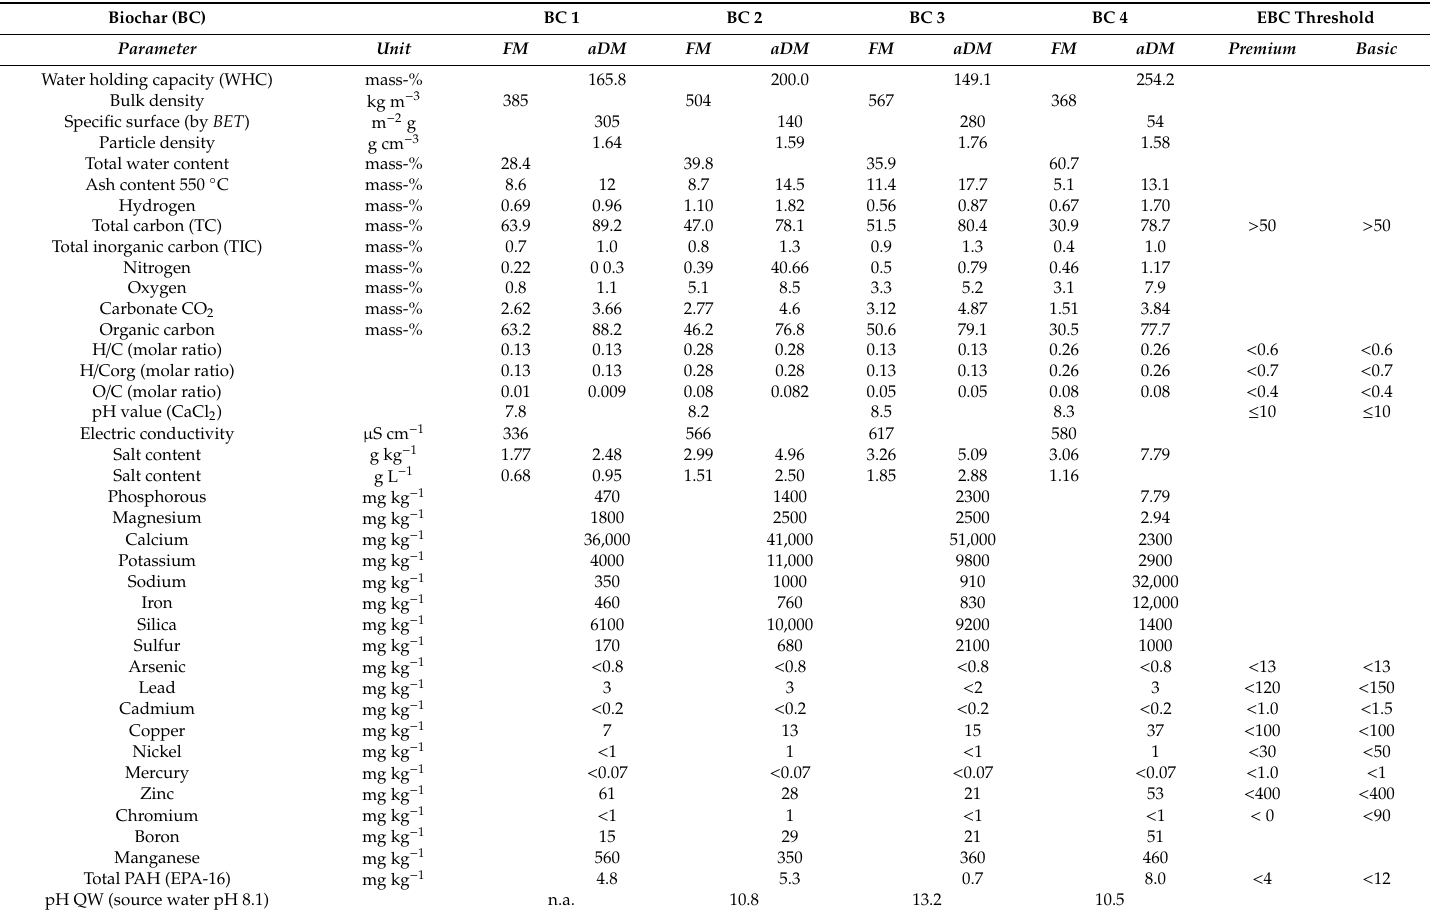
Table 3. Analyses of four BCs based on four di ff erent feedstocks generated with a Kon-Tiki flame curtain kiln in Aguascalientes, Mexico at Universidad Panamericana. Analyzed by an European Biochar Certificate (EBC) accredited laboratory following the EBC analytical methods and compared to the EBC thresholds for premium and basic BC quality 1